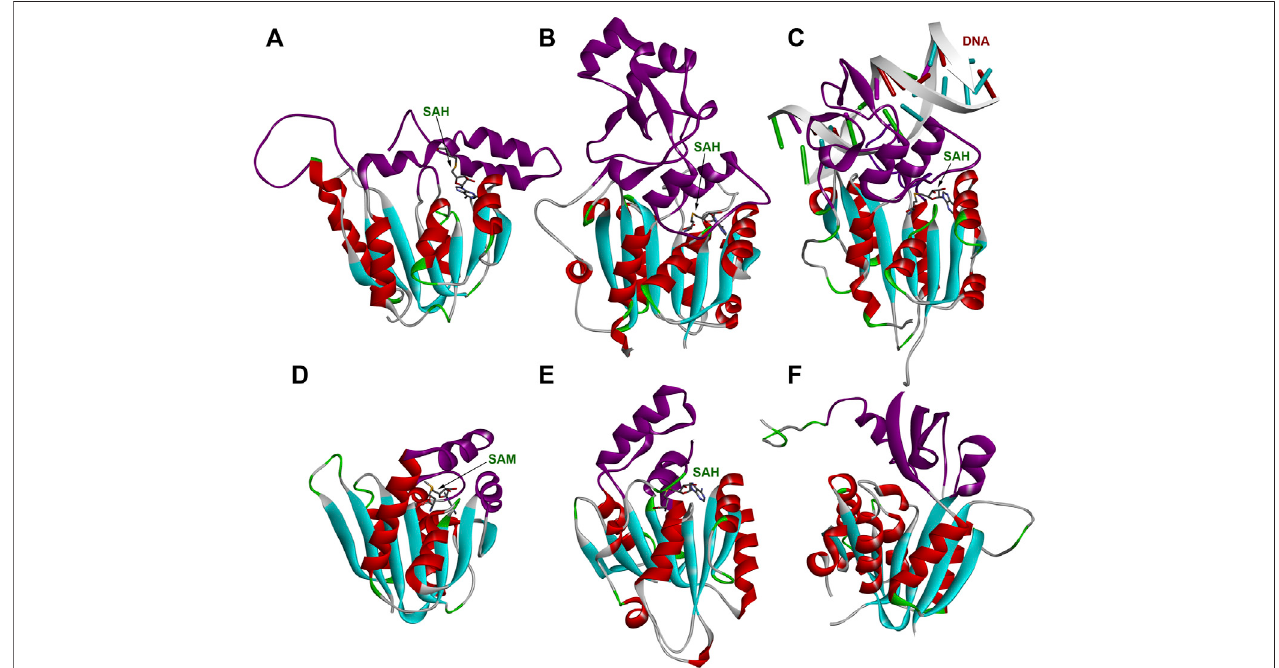
FIGURE9| StructuresofseveralMTases. (A) WBSCR27incomplexwithSAH(PDBid7QCB); (B) S.pombe tRNA Asp MTaseDNMT2incomplexwithSAH(PDBid 6FDF); (C) human DNA MTase DNMT3A in complex with SAH and DNA fragment (PDB id 6BRR); (D) S. cerevisiae rRNA MTase Bud23 (PDB id 4QTU); (E) human tRNA His MTase BCDIN3D in complex with SAH (PDB id 6L8U); (F) human glycine MTase (PDB id 2AZT). Rossmann-fold of the enzymes ’ core is colored in cyan ( β - strands) and red ( α -helices). Substrate-binding domains are colored